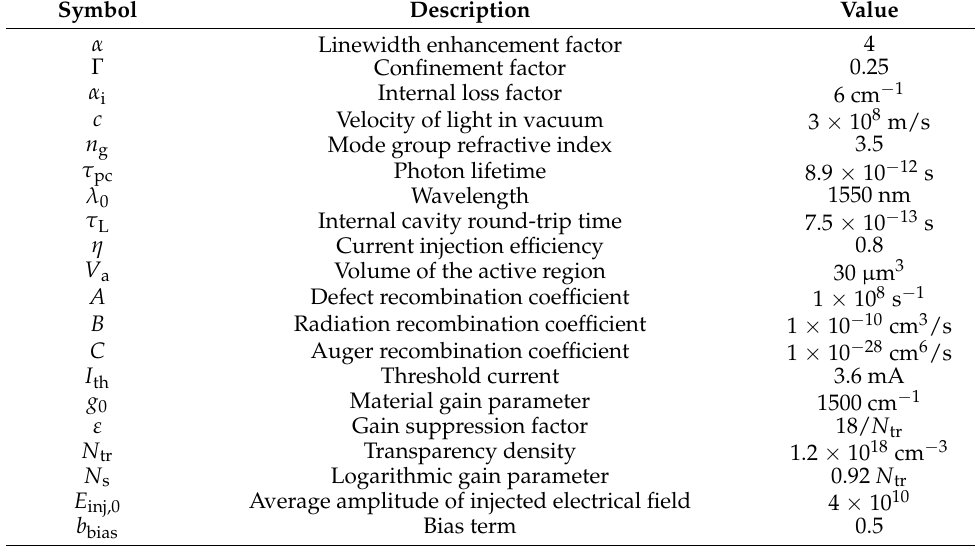
Table 1. Numerical Model